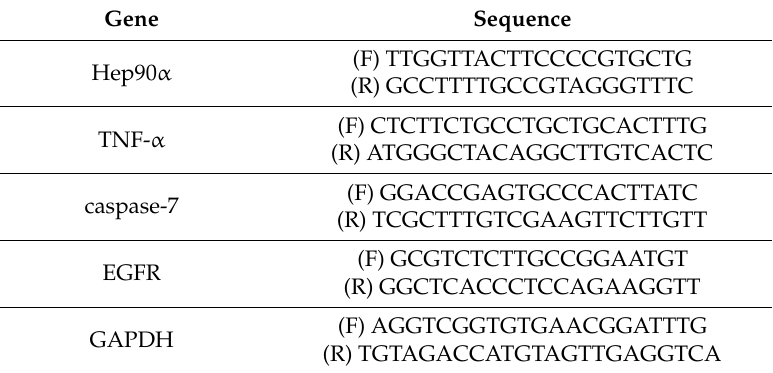
Table 4. Sequence of Hsp90 α , TNF- α , caspase-7, EGFR and GAPDH